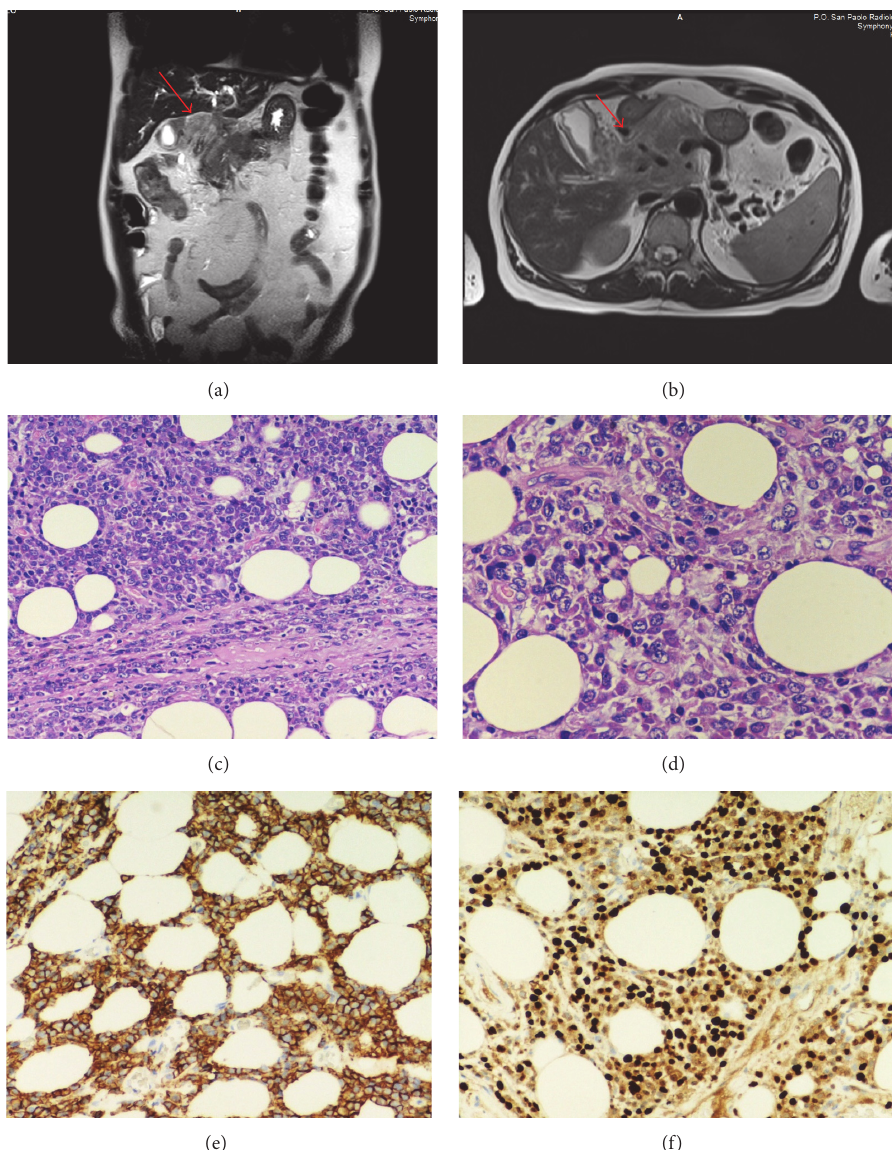
Figure 2: MR cholangiopancreatography before VBD therapy. (a) and (b) show a tumor mass localized at the hepatic hilum without cleavage plane with the head of the pancreas and blood vessels of about 8.35 × 8.7 × 8.9 cm. ((c) and (d)) Hematoxylin and eosin stain. Original magnification × 100 and × 200. The myeloma cell size and nucleus are polymorphic. Many cells have large eccentric nuclei, prominent nucleoli, and abundant basophilic cytoplasm (i.e., nuclear and cytoplasmic maturation asynchrony). (e) The neoplastic cells are positive for CD138. (f) The ki67 labeling index exceeds